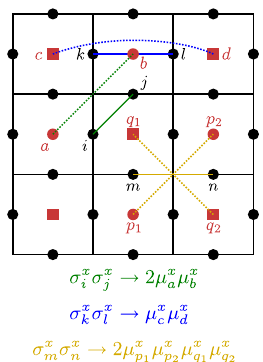
Figure 11: Mapping of the Ising interactions from the TCI to the AT-TFI model. Solid lines show the original interactions, dotted lines (in the same color) the mapped interactions. The two sublattices of the dual square lattice are denoted by red squares / circles. The resulting two-body Ising interactions do not couple the sub- lattices, while the four-body interaction couples